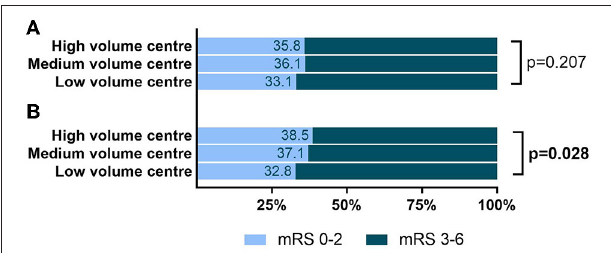
FIGURE 3 | Functional outcome at 90-day follow-up depending on center volume tertile. (A) Study cohort including all patients. No significant difference in good functional outcome in high- vs. low-volume center. (B) Subgroup analysis: only patients primarily admitted to MT center. Higher share of good functional outcome (mRS 0–2) at 90-day follow-up in high- vs. low-volume centers. Displayed: absolute share of mRS-based good functional outcome. Staded are p -values of univariate comparison high- vs. low-volume center resulting from the chi-square test. mRS, modified Rankin scale.